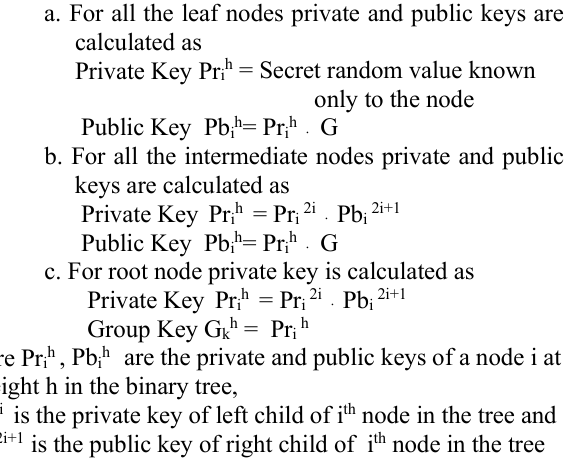
Figure 2. A lgorithm for Group Key